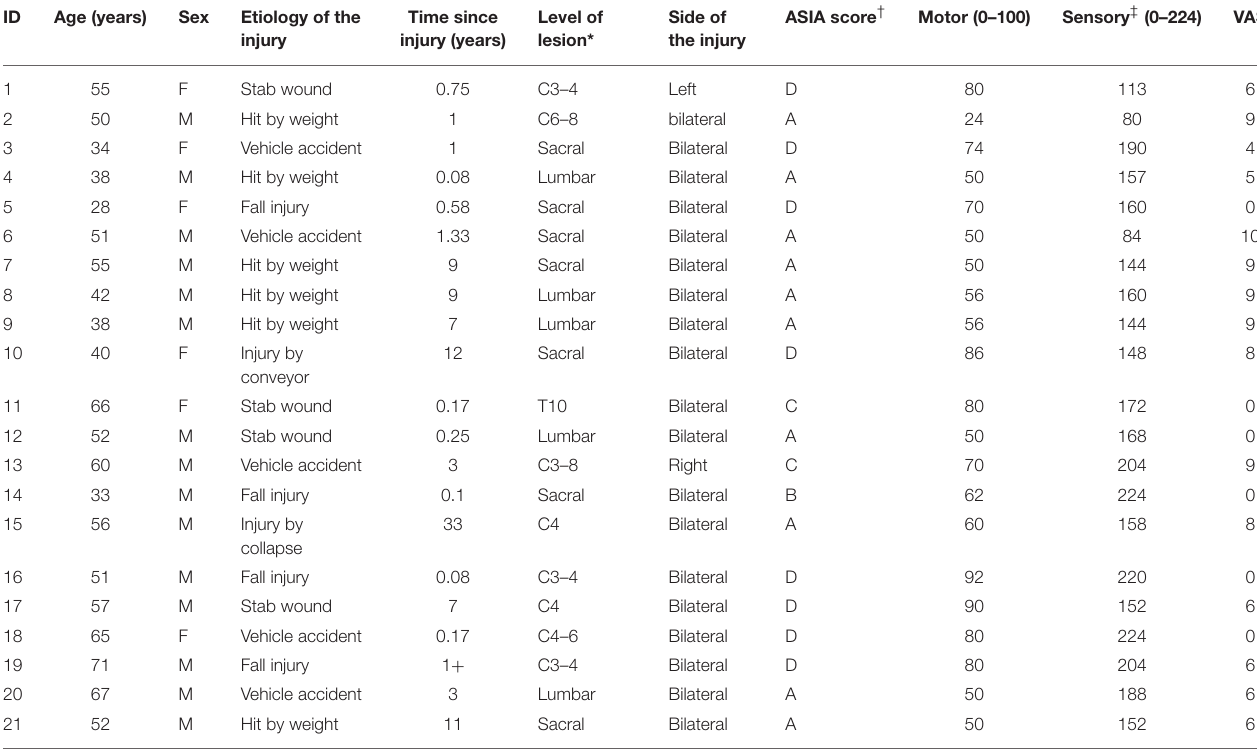
TABLE 1 | Clinical data for the individuals with spinal cord